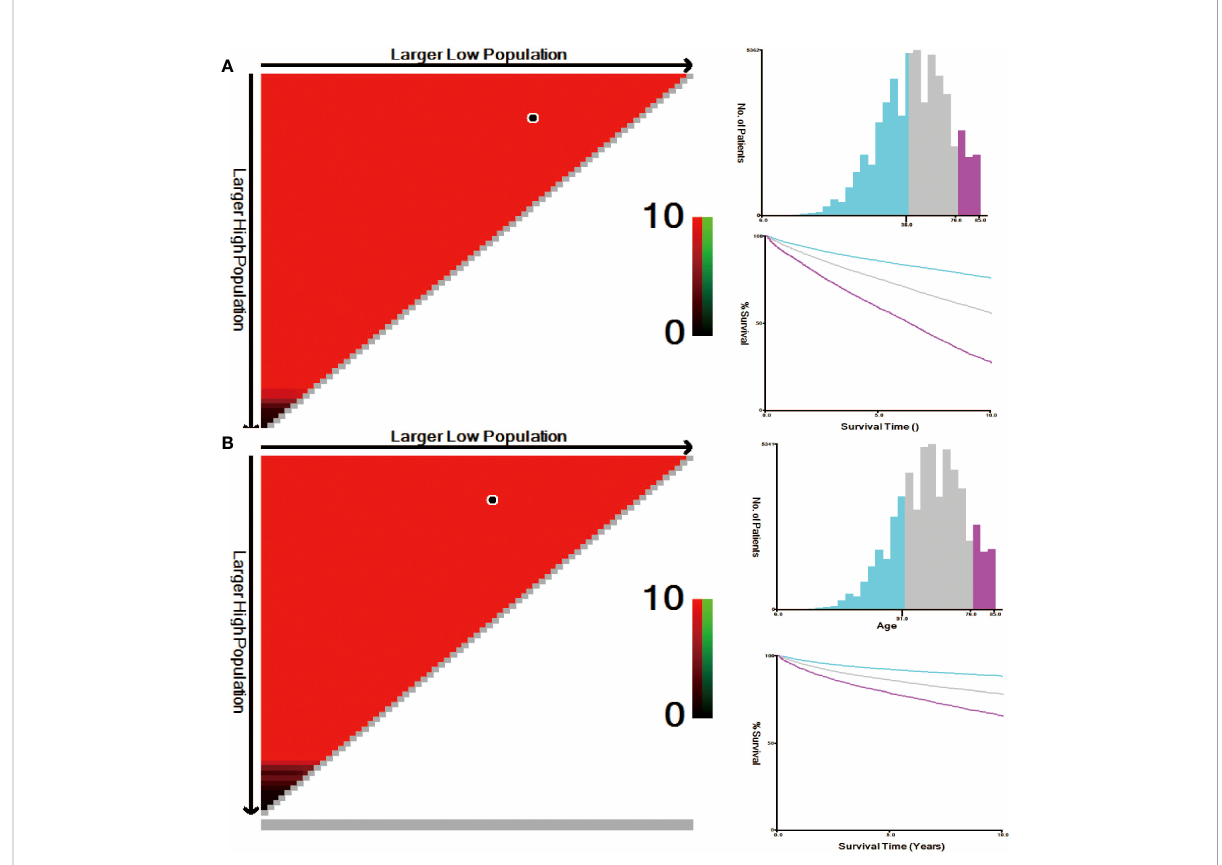
FIGURE 4 (A) Optimal cut-off point for OS de fi ned with X-tile software; (B) Optimal cut-off point for CSS de fi ned with X-tile